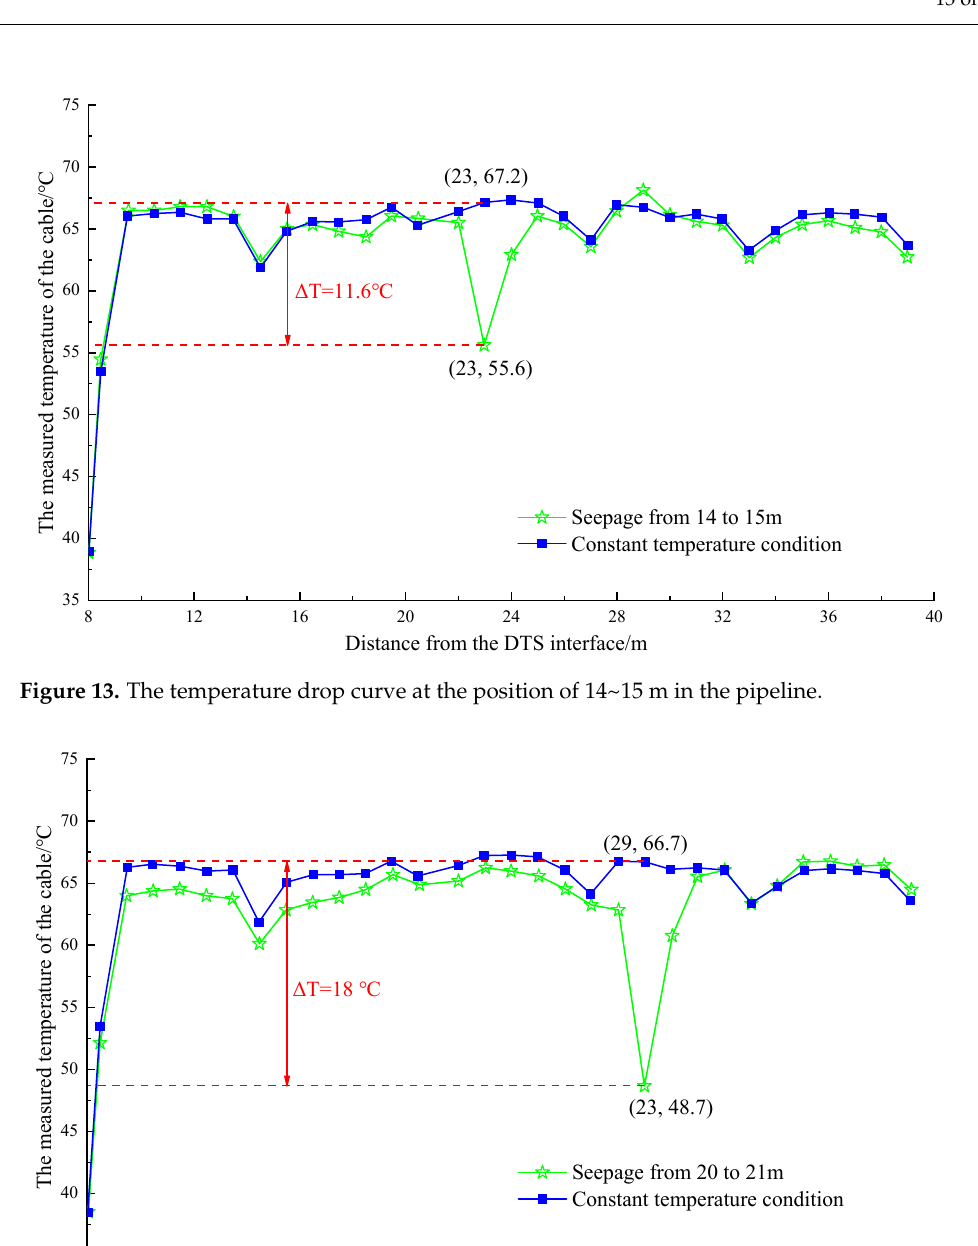
Figure 13. The temperature drop curve at the position of 14~15 m in the pipeline.